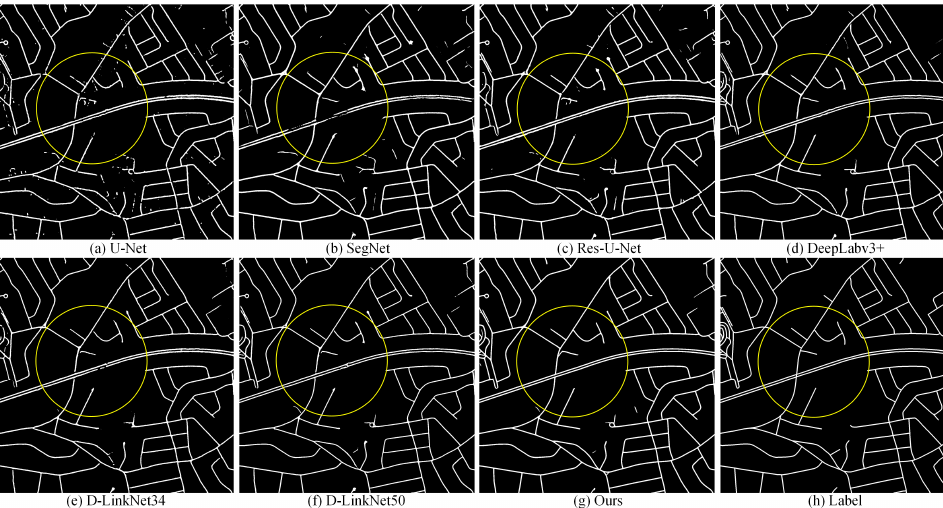
Figure 9. Extracted sample of related methods on the Massachusetts